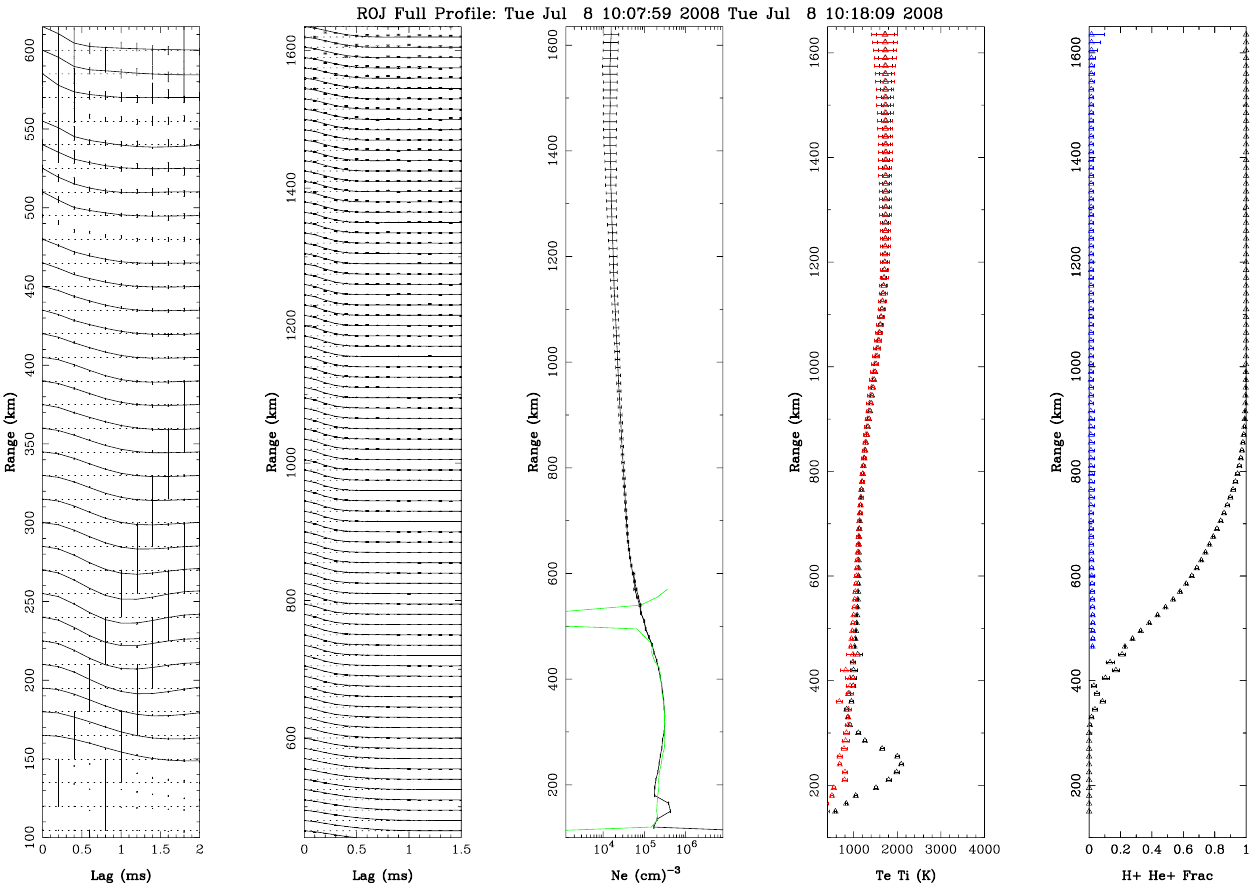
Fig. 2. Full-profile analysis results for the morning of 8 July 2008 from 10:08–10:18LT. From left to right, the columns represent double- pulse autocorrelation functions, long-pulse lag products, plasma number density, plasma temperature (electrons = black symbols, ions = red symbols), and light-ion fraction (H + =black, He +